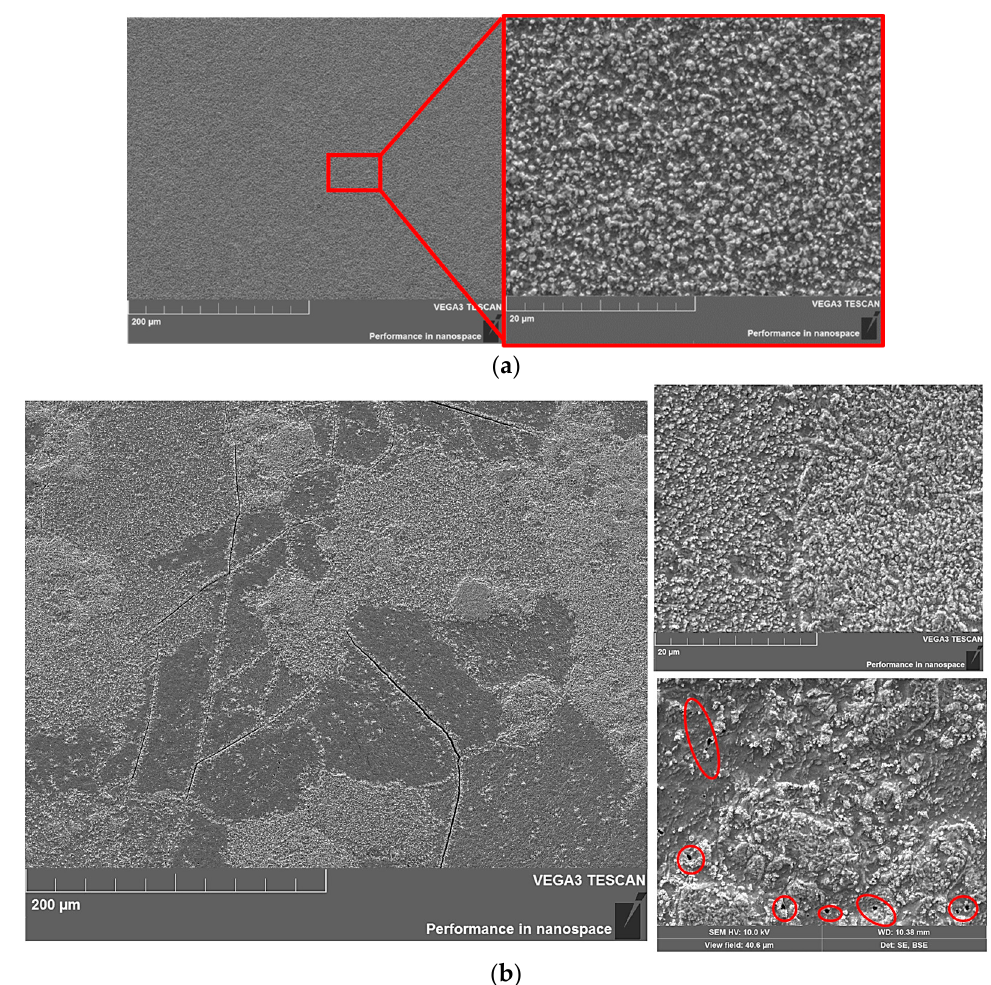
Figure 8. Microstructure of the surface of tungsten samples with a W 2 C carbide layer after irradiation with helium plasma at different temperatures (the locations of pores is marked in red). ( a ) Sample No. 5 ~905 ◦ C , ( b ) sample No. 6 ~1750 ◦ C